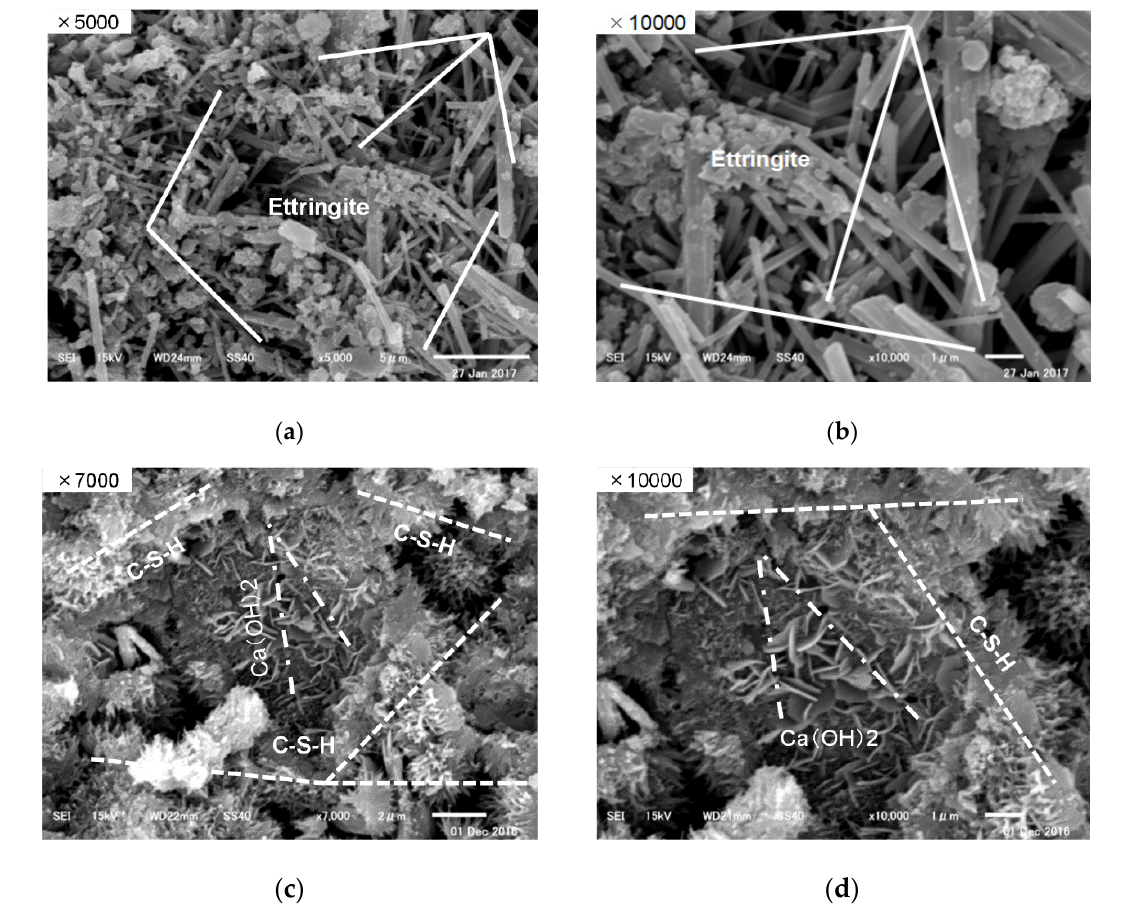
Figure 16. SEM observation. ( a ) Steam curing (×5000), ( b ) Steam curing (×10,000), ( c ) MW 3 (×7000), ( d ) MW 3 (×10,000).